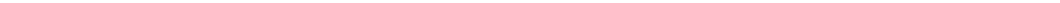
(see fi gure on previous page) Fig. 2 OsSAPK6 physically interacts with and phosphorylates IPA1. a Subcellular localization of IPA1 and OsSAPK6 in rice protoplasts. Scale bars, 5 µm. b BiFC showing the interaction between IPA1 and OsSAPK6 in rice protoplasts. Scale bars, 5 µm. c BiFC showing the interaction between OsSPLs and OsSAPK6 in rice protoplasts. Scale bars, 10 µm. d Co-IP assays demonstrating the interaction between IPA1 and OsSAPK6. e HA-IPA1 but not HA-IPA1 1 – 181 could be co-immunoprecipitated when OsSAPK6-GFP was pulled down from protoplast extracts. f Yeast two-hybrid assays demonstrating the interaction between IPA1 and OsSAPK6. g IPA1 phosphorylation mediated by OsSAPK6 in vitro. The puri fi ed recombinant OsSAPK6-His and GST-IPA1 were incubated in protein kinase buffer and separated on 12% (w/v) SDS-PAGE containing 50 µM Phos-tag. h Detection of phosphorylation of GST-IPA1, GST-IPA1 S201A , GST-IPA1 S213A , and GST-IPA1 S201A213A by OsSAPK6 in vitro. Recombinant proteins were incubated with OsSAPK6, separated in a Phos-tag gel, and detected with anti-GST monoclonal antibody. See also Supplementary Fig. S3 and Table S1.